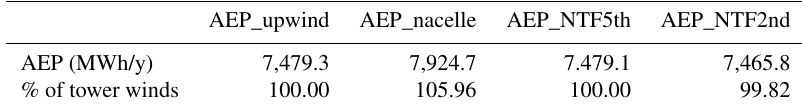
Table 3. Top row shows Annual energy production (AEP) in megawatt hours per year calculated using upwind tower measure- ments (AEP_upwind), nacelle winds (AEP_nacelle), corrected nacelle winds using the NTF calculated with a fifth-order polynomial (AEP_NTF5th), and corrected nacelle winds using the NTF calculated with a second-order polynomial (AEP_NTF2nd). Bottom row shows AEP in percentage calculated as a percentage of AEP_upwind.